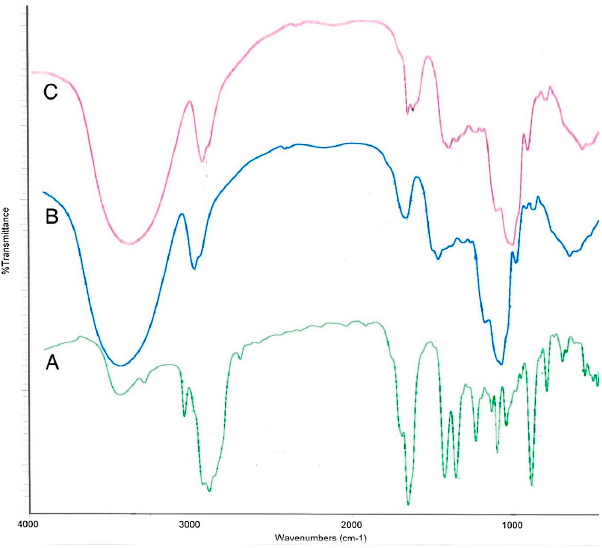
Figure 25. FTIR spectra of ( A ) pure SEO, ( B ) pure matrix, and ( C ) inulin and arabic gum-based microcapsules [209].